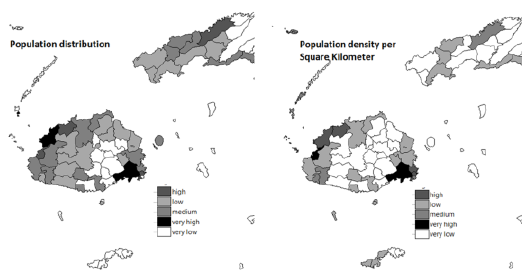
Figures 9a. Fiji islands map showing population distribution (as percentage of population) per tikina . Range: 0 to 14.4. Figure 9b. The country‘s map showing